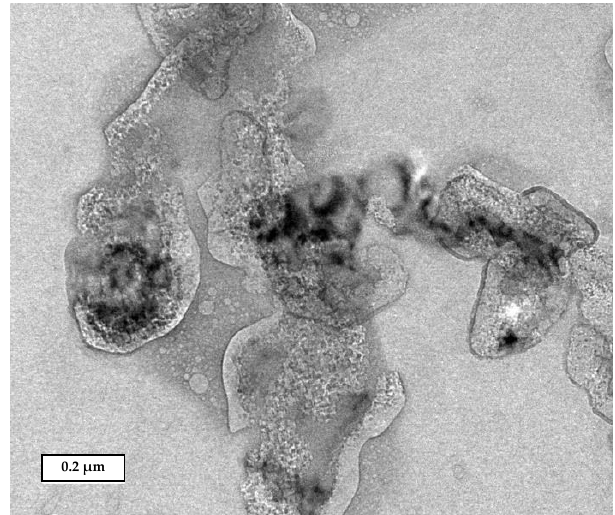
Figure 1. Transmission electron micrograph of FPV-SLN formulation.